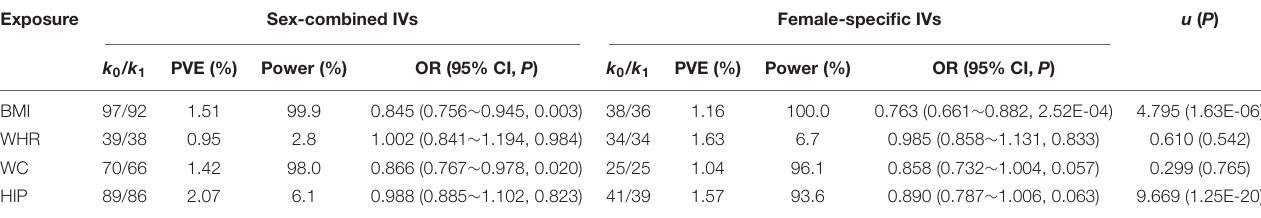
TABLE 3 | Association of anthropometric trait with the risk of breast cancer using sex-combined and female-specific instruments. Exposure